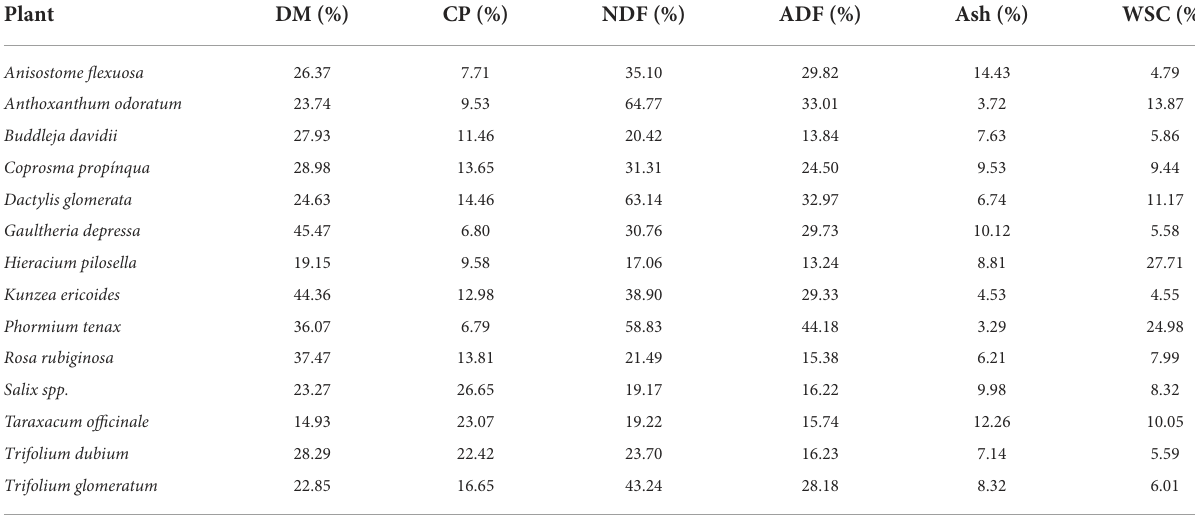
TABLE 3 Primary nutrients composition (% of DM) of 14 plants purposely selected in terms of phytochemical and nutraceutical composition. Plant